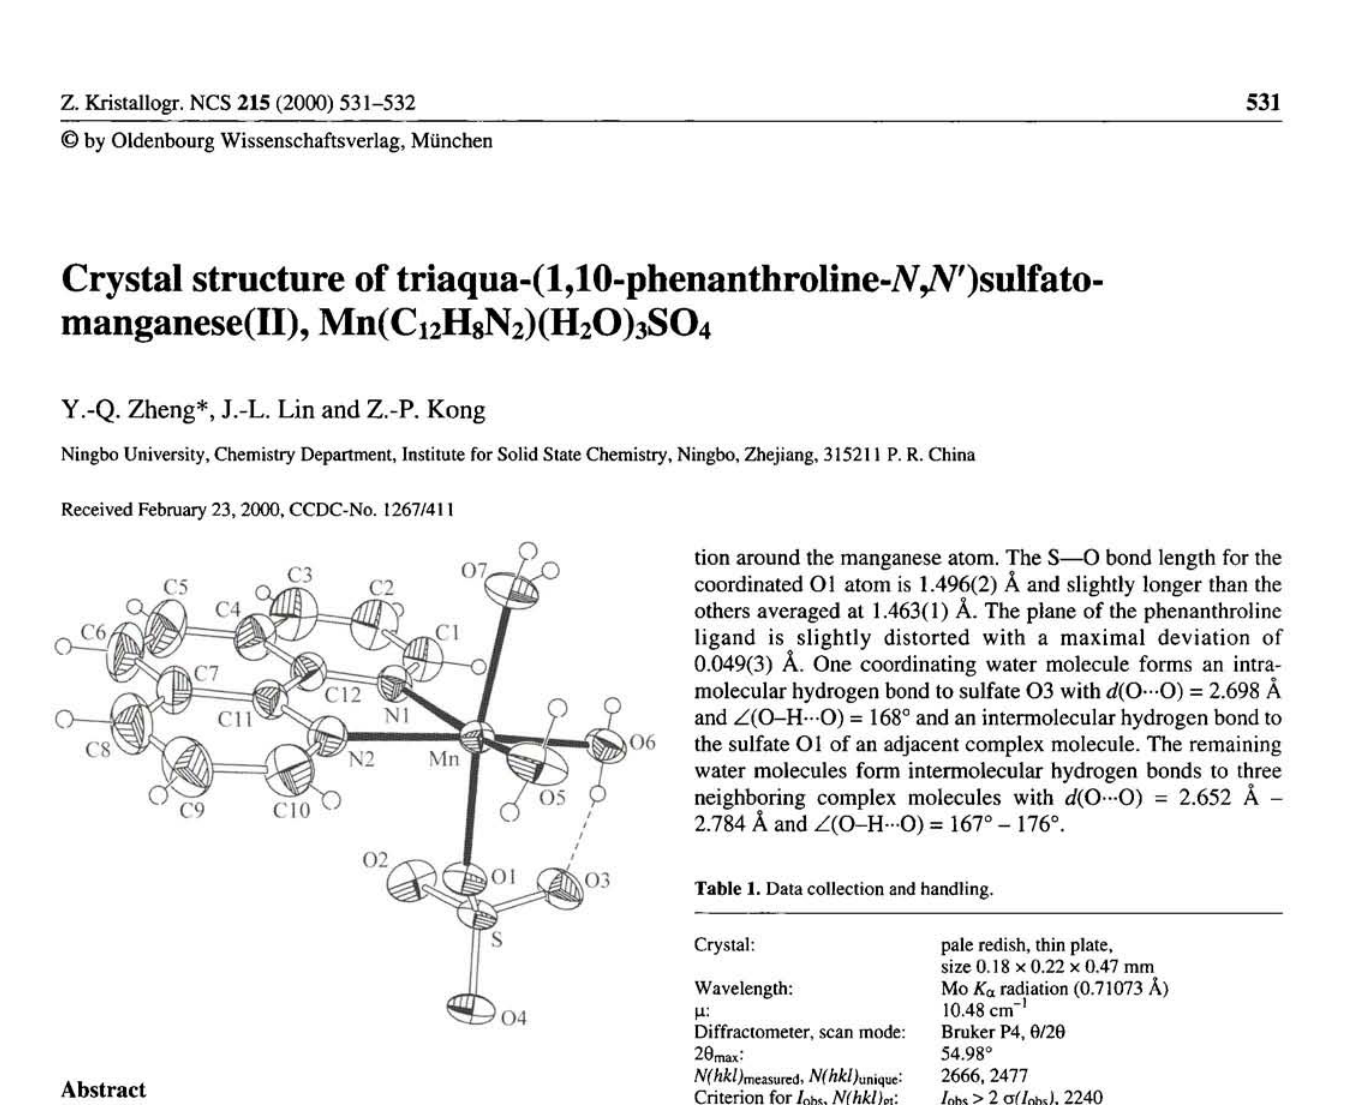
Table 2. Atomic coordinates and displacement parameters (in Â 2